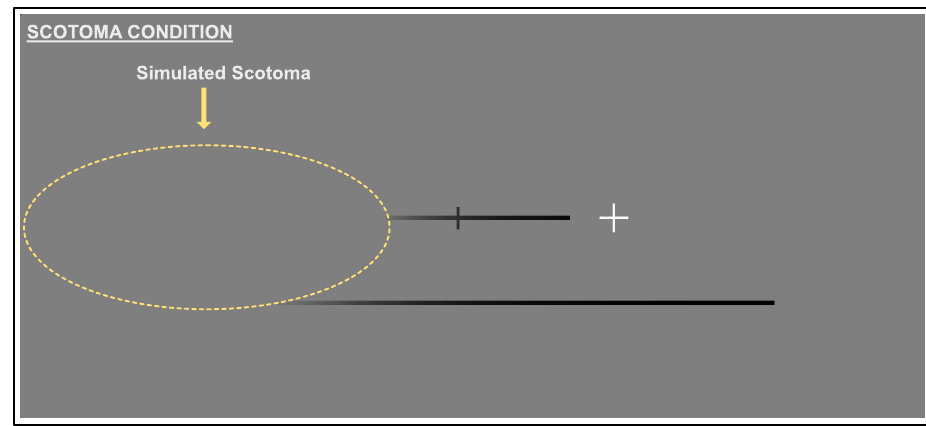
Figure 2. Scotoma Condition: The same configuration as the baseline condition, but a grey oval (smoothed by a Gaussian luminance profile) was overlayed so as to obscure a proportion of the target line. The cursor was not visible when within the